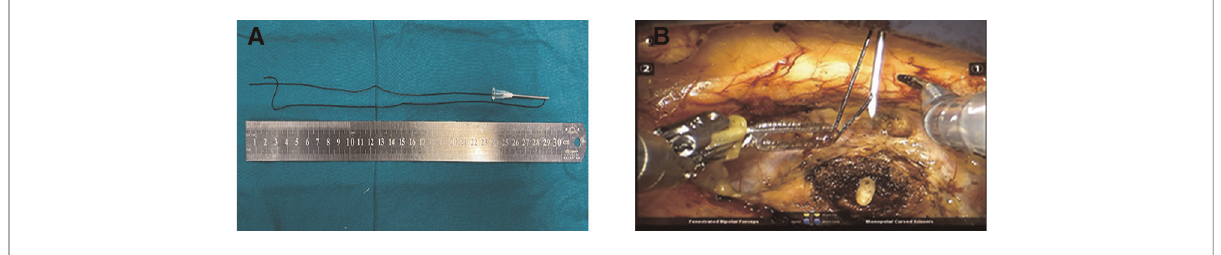
FIGURE 2 Homemade abdominal puncture device and its application points. ( A ) The abdominal puncture needle was made by inserting retraction sutures into the needle of a 20 ml syringe. ( B ) The needle was inserted vertically into the abdominal wall near the midline of the pubic symphysis, and the retraction sutures were pulled out by a robotic